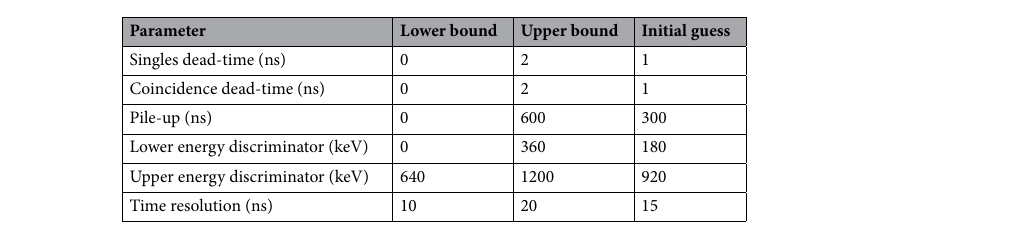
Table 2. Digitizer parameter bounds and initial